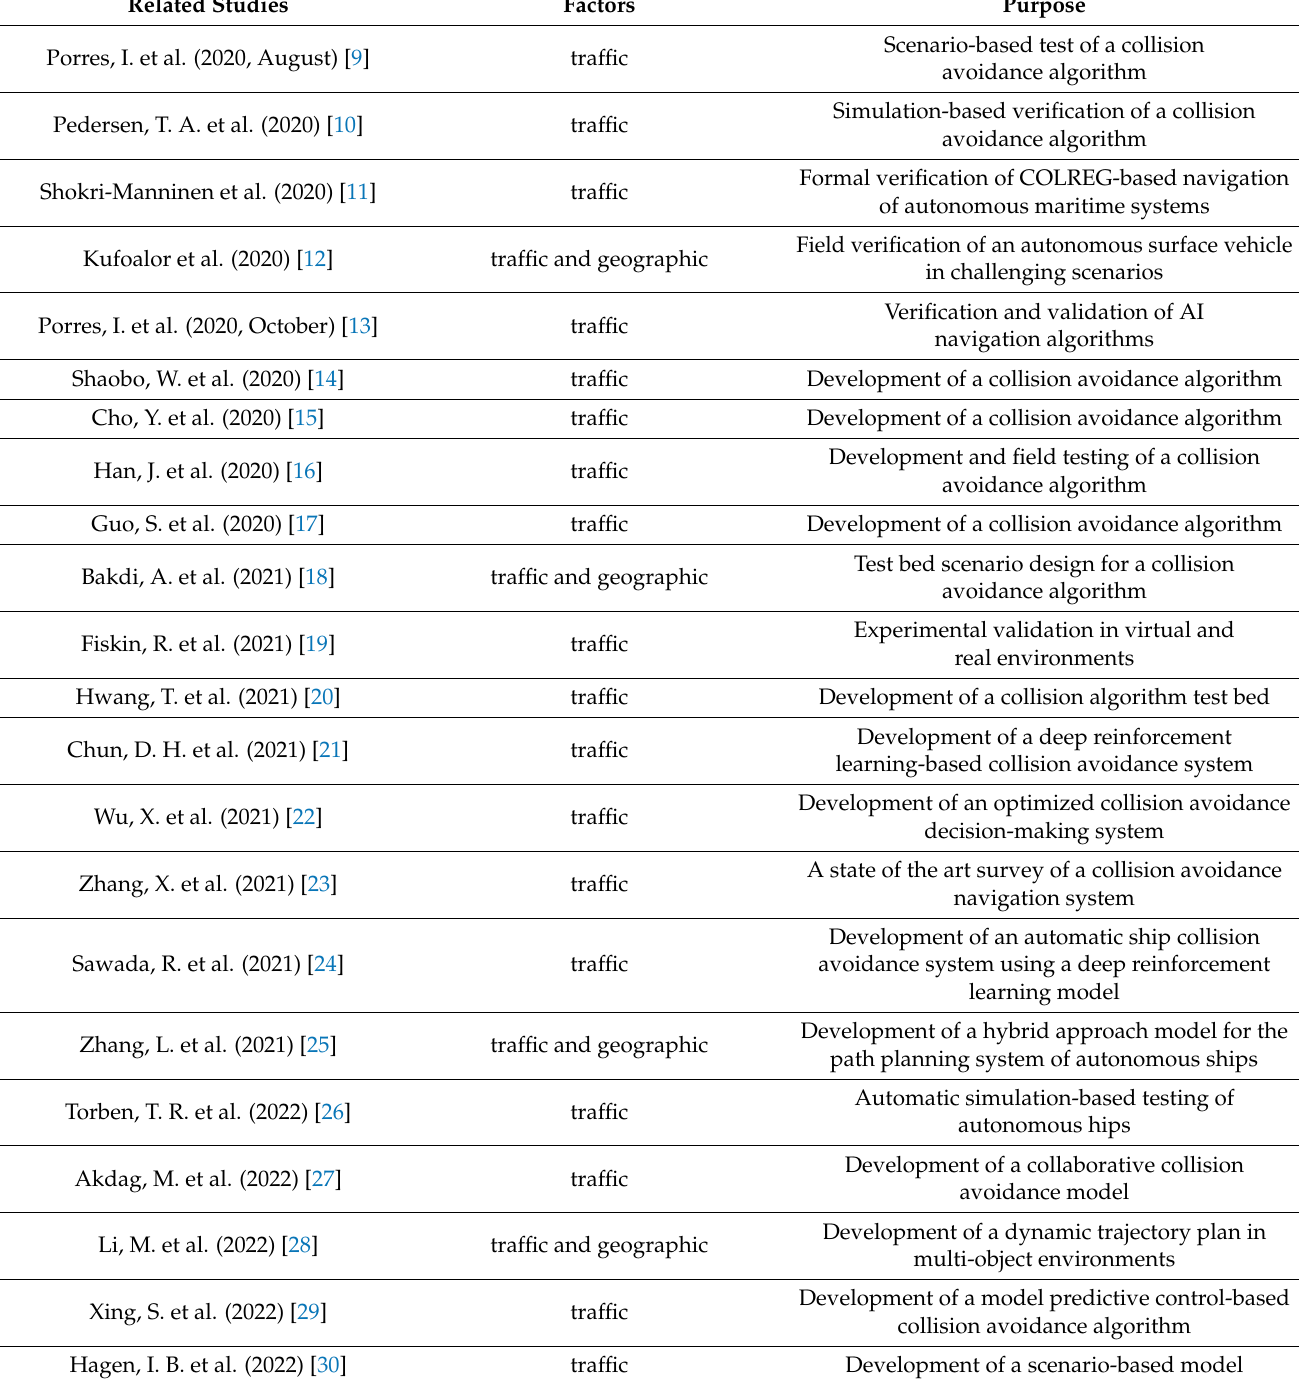
Table 1. Related studies on collision avoidance system